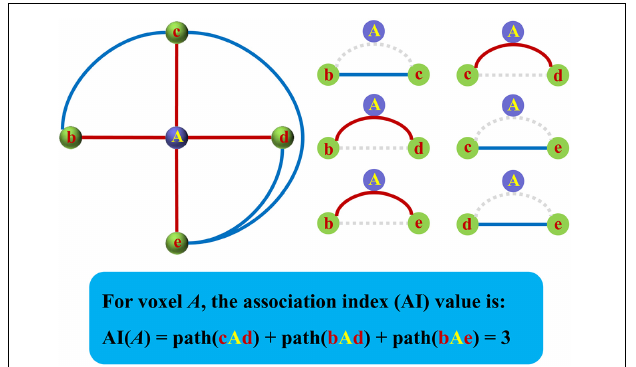
FIGURE 1 | The diagram for the calculation of the association index (Asso). The Asso was defined as the total number of functional connections of this voxel to all other voxels of the rest brain above a predefined threshold minus the number of interconnected functional connections of the rest brain above the same